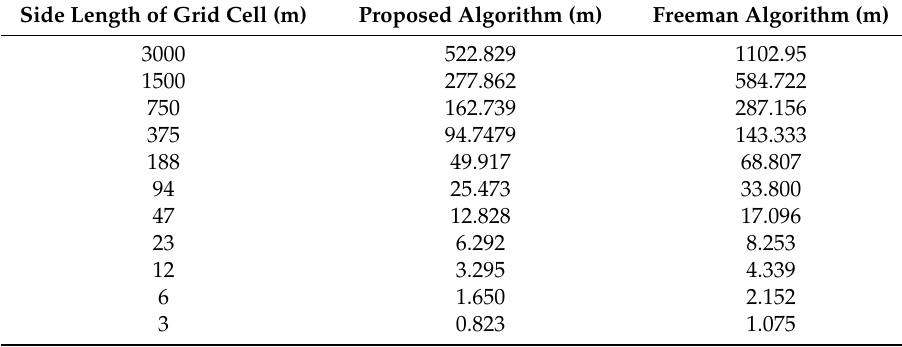
Table 1. Average distance (AVD) statistical table for Freeman and proposed